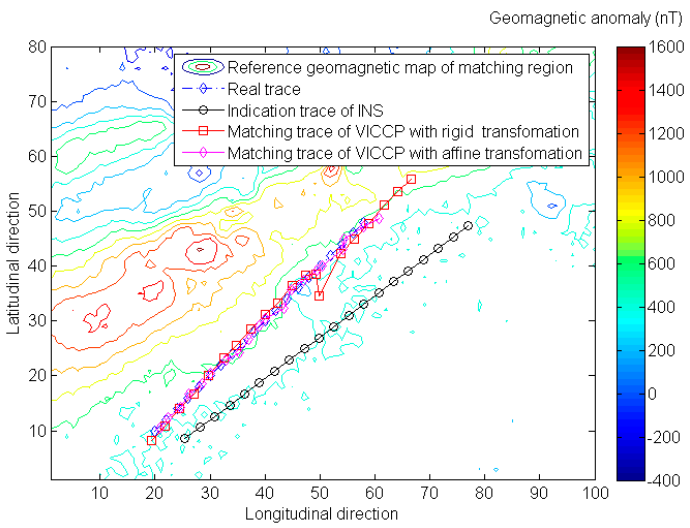
Figure 5. The comparison of geomagnetic matching results for VICCP with rigid transformation and affine transformation. Table 4. Comparison of VICCP with different transformation for 100 times Monte Carlo simulation.